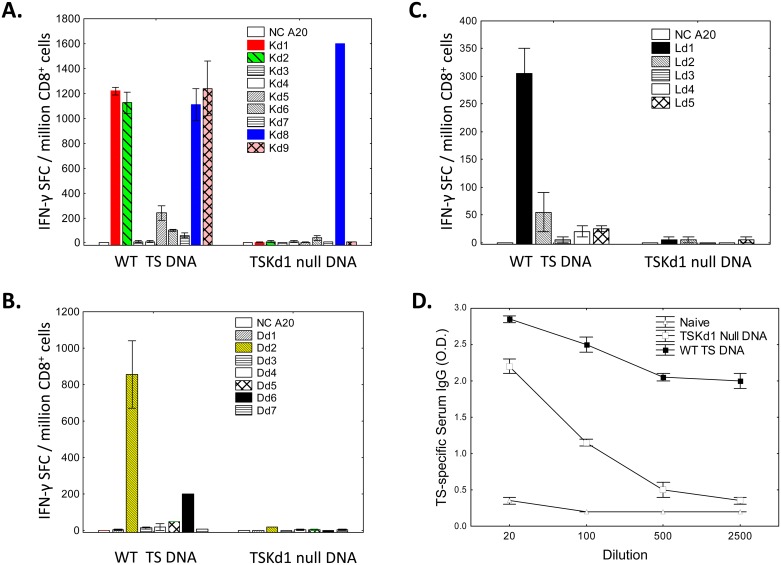
The WT DNA vaccine induces CD8+ T cell responses directed against both immunodominant and subdominant T cell epitopes.BALB/c mice were vaccinated i.m. twice, two weeks apart with 100μg of WT TS DNA or TSKd1 null TS DNA. Four weeks later, CD8+ splenic T cells from these vaccinated mice were stimulated overnight in IFN-γ ELISPOT assays with APC (A20 cells) pulsed with TS peptides predicted to bind BALB/c MHC [H2-Kd (A), H2- Dd (B) and H2-Ld(C). Results are representative of 3 experiments. As expected, vaccination of mice with WT but not TSKd1 null TS DNA constructs elicited T cell responses to TSKd1. CD8+ T cells from WT TS DNA vaccinated mice also responded to TS peptides Kd2, Kd5, Kd6, Kd7, Kd8, Kd9, Dd2, Dd6, Ld1 and Ld2, while cells from TSKd1 null vaccinate mice responded to only TS Kd8. Mutation of the 2 binding residues of TSKd1 to H2-Kd1 resulted in a marked immunofocusing of CD8+ T cell responses. Panel D further shows that WT TS DNA vaccination induced higher levels of TS-specific antibody, compared with TSKd1 null DNA vaccination.